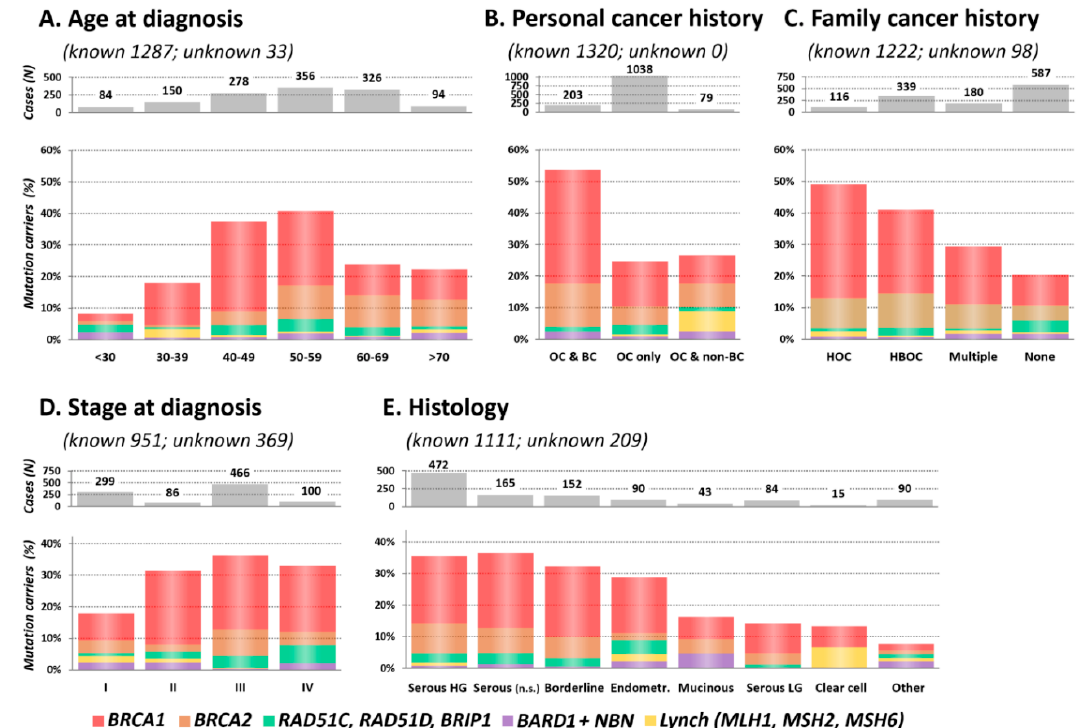
Figure 2. Proportion of mutation carriers in clinicopathological subgroups, including ( A ) Age at OC diagnosis; ( B ) Personal cancer history; ( C ) Family cancer history; ( D ) Stage at diagnosis; ( E ) Histology in 1320 OC patients..